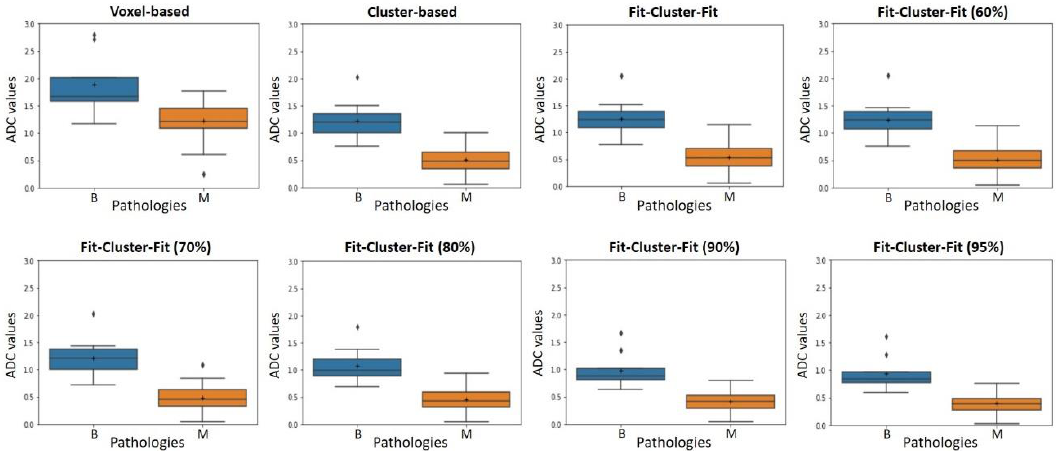
Figure 5. Box-and-whisker plot representations of the apparent diffusion coefficient (ADC, 10 −3 mm 2 /s) for benign (B) and malignant (M) neuroblastic tumors in voxel-based, cluster-based and Fit-Cluster-Fit models, applying different confidence thresholds to exclude uncertainties (60%, 70%, 80%, 90% and 95%). Outliers are plotted as individual points.